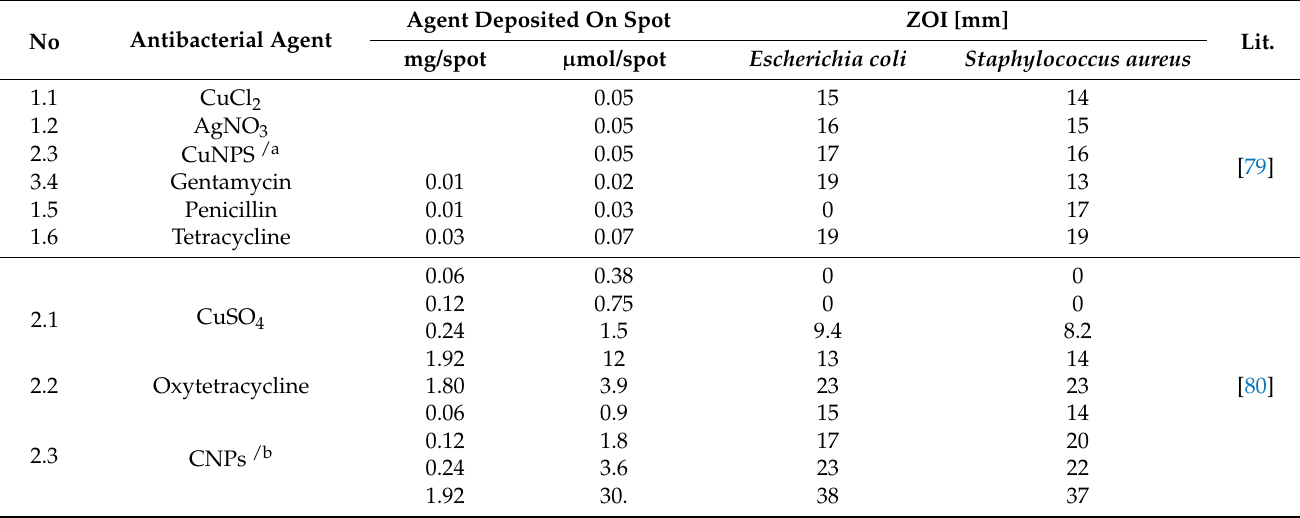
Table 12 summarizes the antibacterial properties of various metal salts/nanoparticles and antibiotics against representative gram positive ( Escherichia coli ) and gram negative ( Staphylococcus aureus ) bacteria. Table 12. Antibacterial properties of various metal salts/nanoparticles and antibiotics against representative gram positive ( Escherichia coli ) and gram negative ( Staphylococcus aureus ) bacteria, reflexed by their zone of growth inhibition (ZOI). Agent Deposited On No Antibacterial Agent